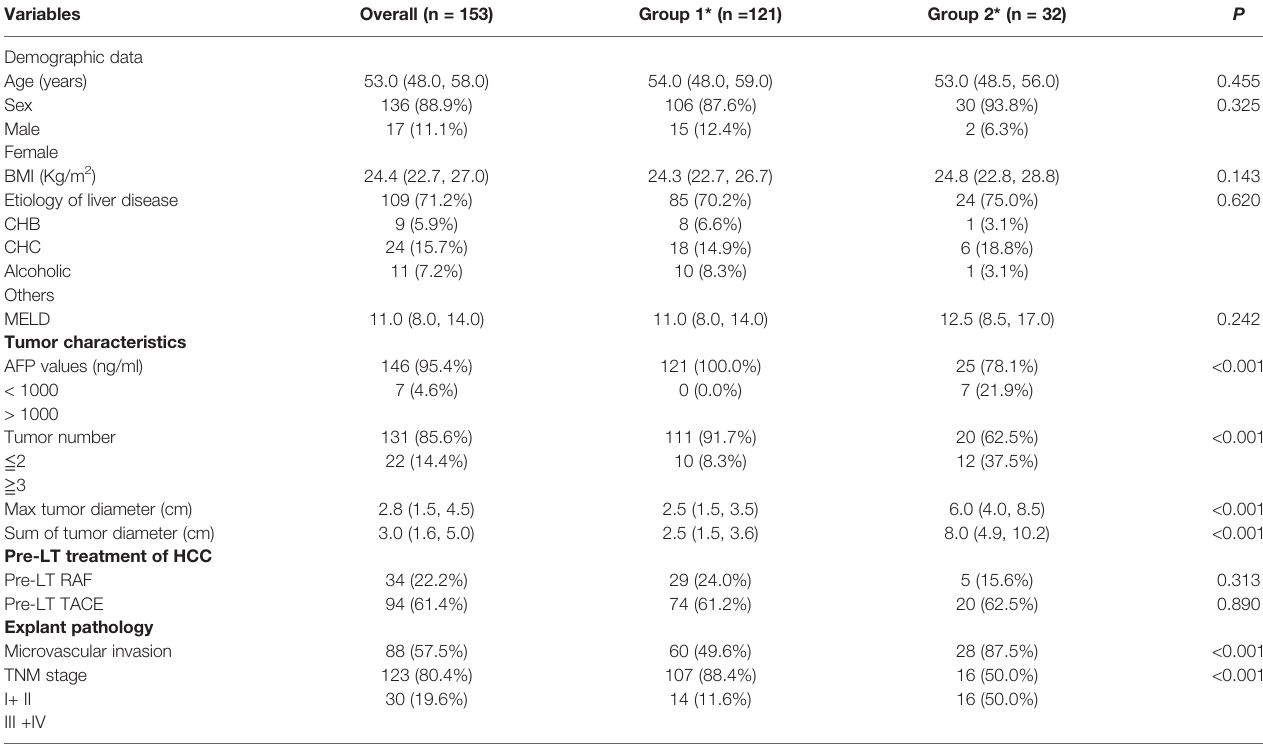
TABLE 3 | Baseline of patients with HCC who met the “ Up-to-seven ” criteria and had AFP of < 1000 ng/mL. Variables Demographic data Age (years)